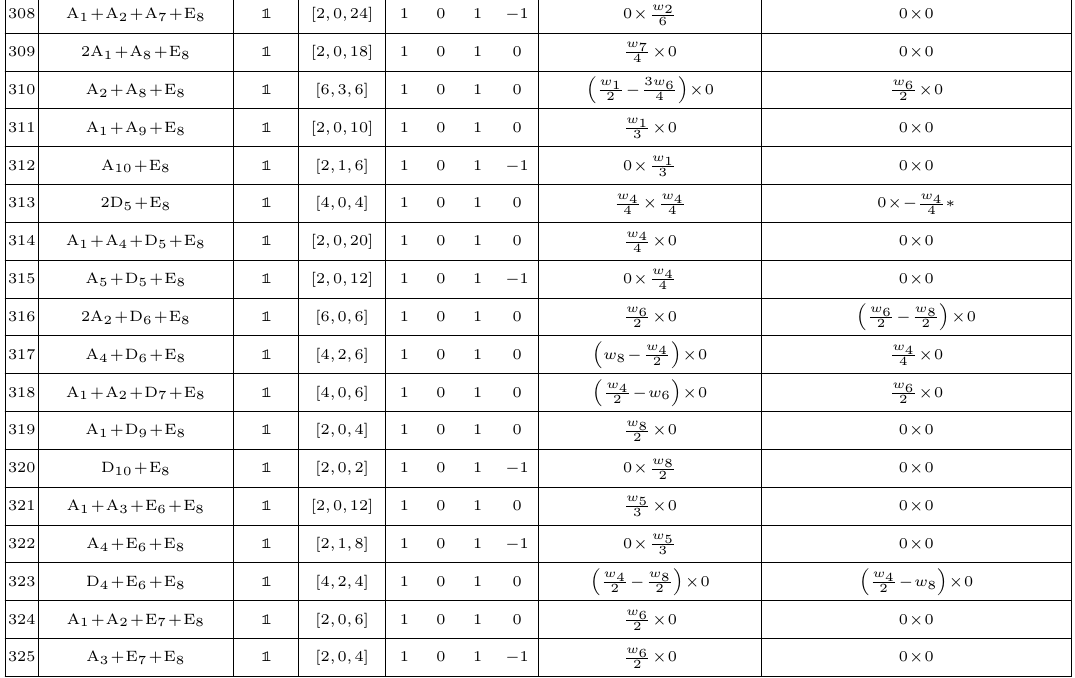
Table 12. Data for all allowed groups of maximal rank, for the E 8 (cid:2) E 0 next to A 2 indicates that the moduli were derived with the Fixed Wilson line or the Neighborhood algorithm. Other moduli were obtained with the method of extended diagrams.